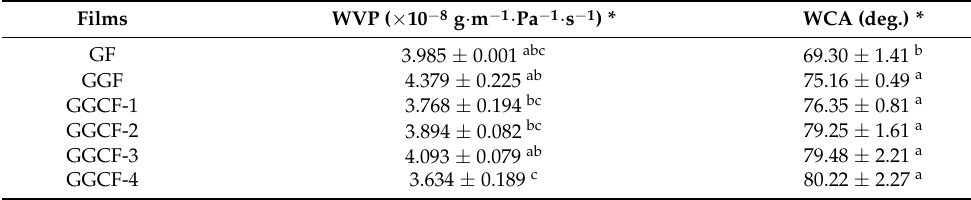
Table 2. Water vapor permeability (WVP) and water contact angle (WCA) of